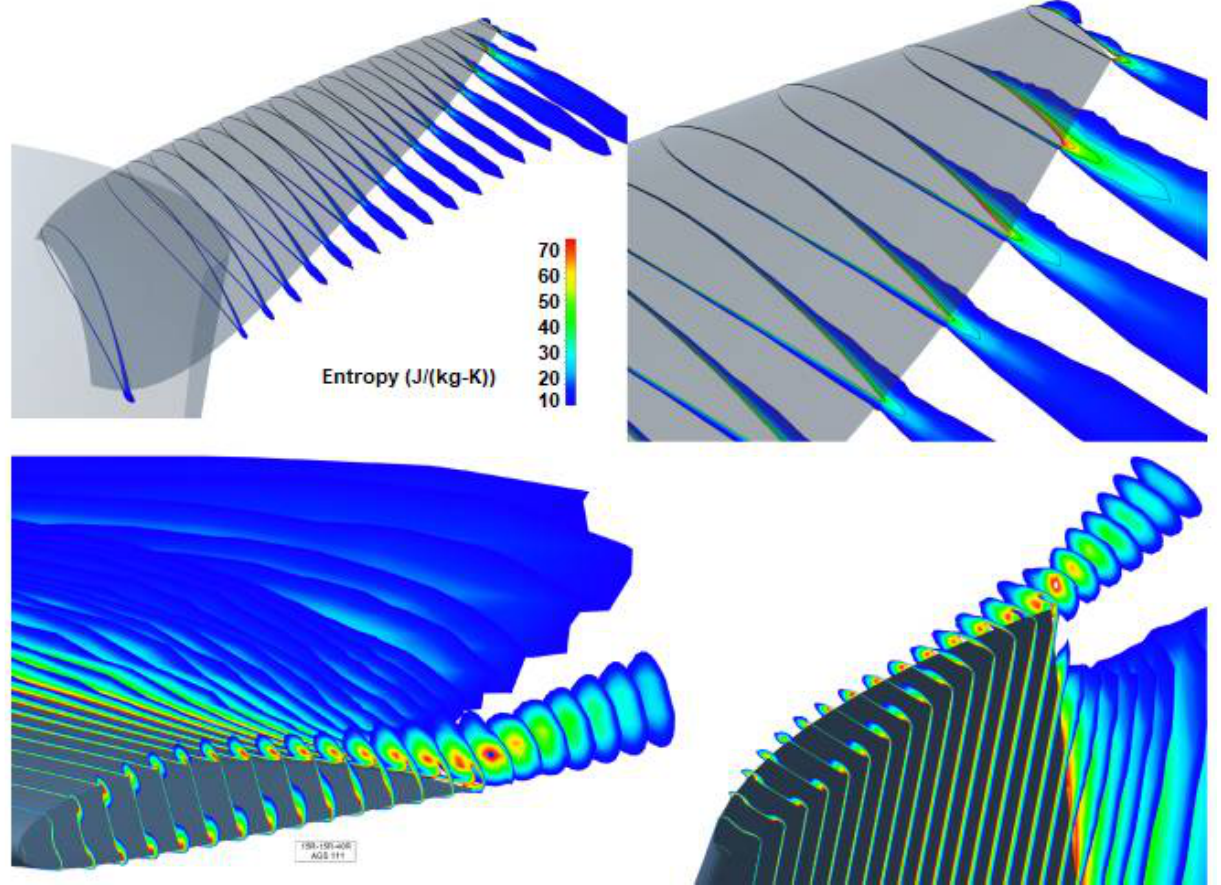
Figure 20. Entropy contours [0–75 units] representing tip and wake loss in 3D steady CFD